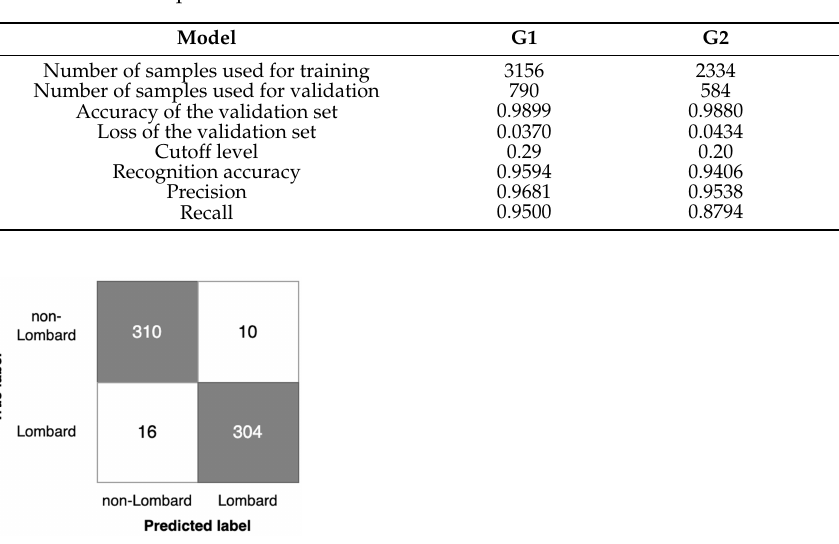
Table 8. Lombard speech detection results.